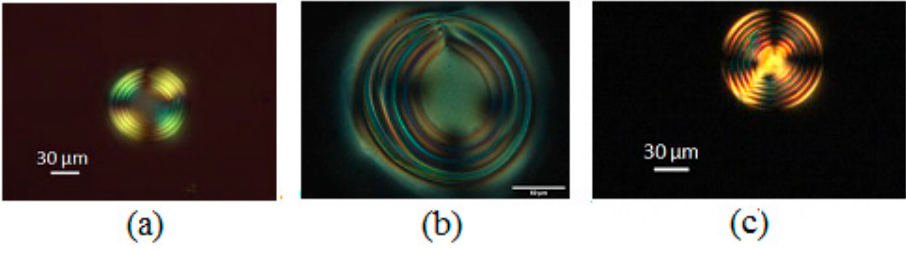
Figure 13. DSCG 13 wt% and L-alanine 10 wt% in ( a ) paraffin, ( b ) silicon oil and ( c ) PDMS.